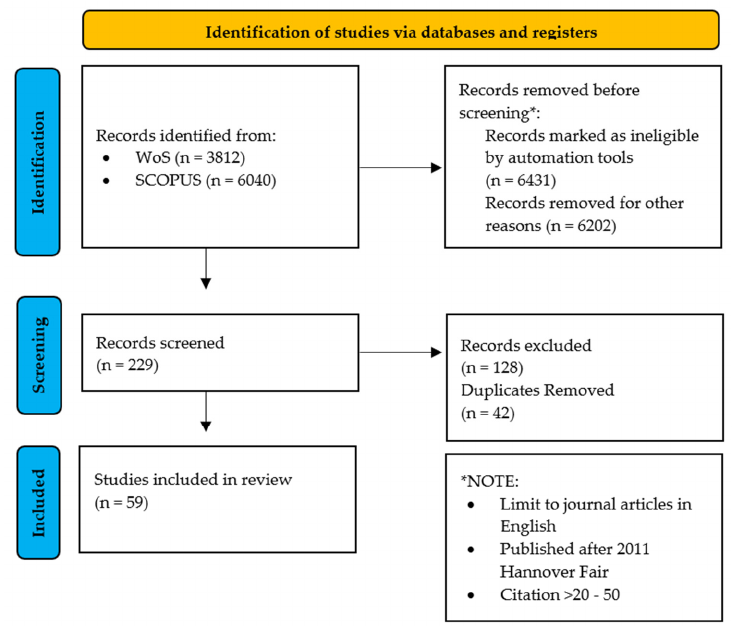
Figure 1. Systematic search results (Source: Page MJ, McKenzie JE, Bossuyt PM, Boutron I, Hoffmann TC, Mulrow CD, et al. The PRISMA 2020 statement: an updated guideline for reporting systematic reviews. BMJ 2021 , 372 , n71. http://doi.org/10.1136/bmj.n71).